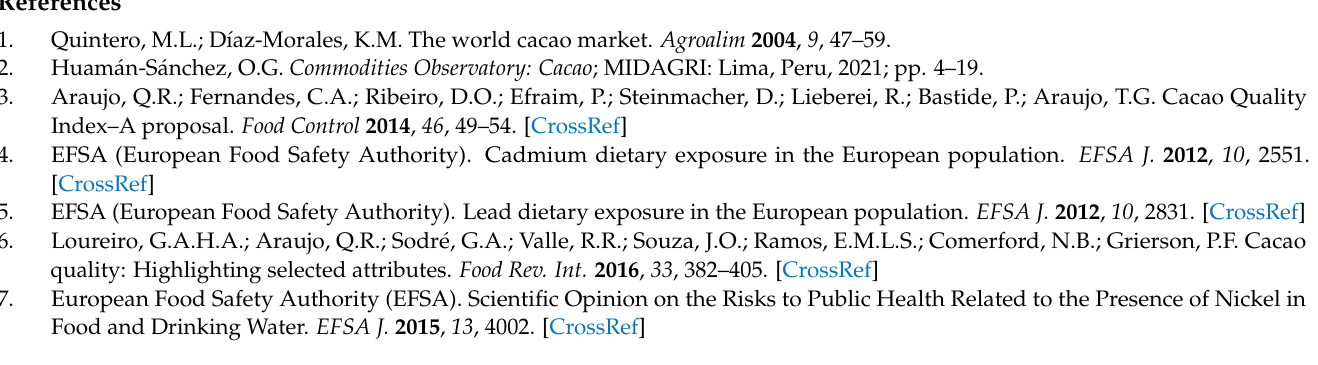
Table S3: ANOVA analysis of treatment D2 between G1 and G3 with respect to negative control D0, Table S4: Tukey Comparative, Table S5: ANOVA analysis of treatment D3 between G1 and G3 with respect to negative control D0, Table S6: Tukey Comparative, Table S7: ANOVA analysis of treatment D1 between G1 and G2 with respect to negative control D0, Table S8: Tukey Comparative, Table S9: ANOVA analysis of treatment D2 between G1 and G3 with respect to negative control D0, Table S10: Tukey Comparative, Table S11: ANOVA analysis of treatment D3 between G1 and G3 with respect to negative control D0, Table S12: Tukey Comparative, Table S13: ANOVA analysis of treatment D1 between G1 and G2 with respect to negative control D0, Table S14: Tukey Comparative, Table S15: ANOVA analysis of treatment D2 between G1 and G3 with respect to negative control, Table S16: Tukey Comparative, Table S17: ANOVA analysis of treatment D3 between G1 and G3 with respect to negative control D0, and Table S18: Tukey